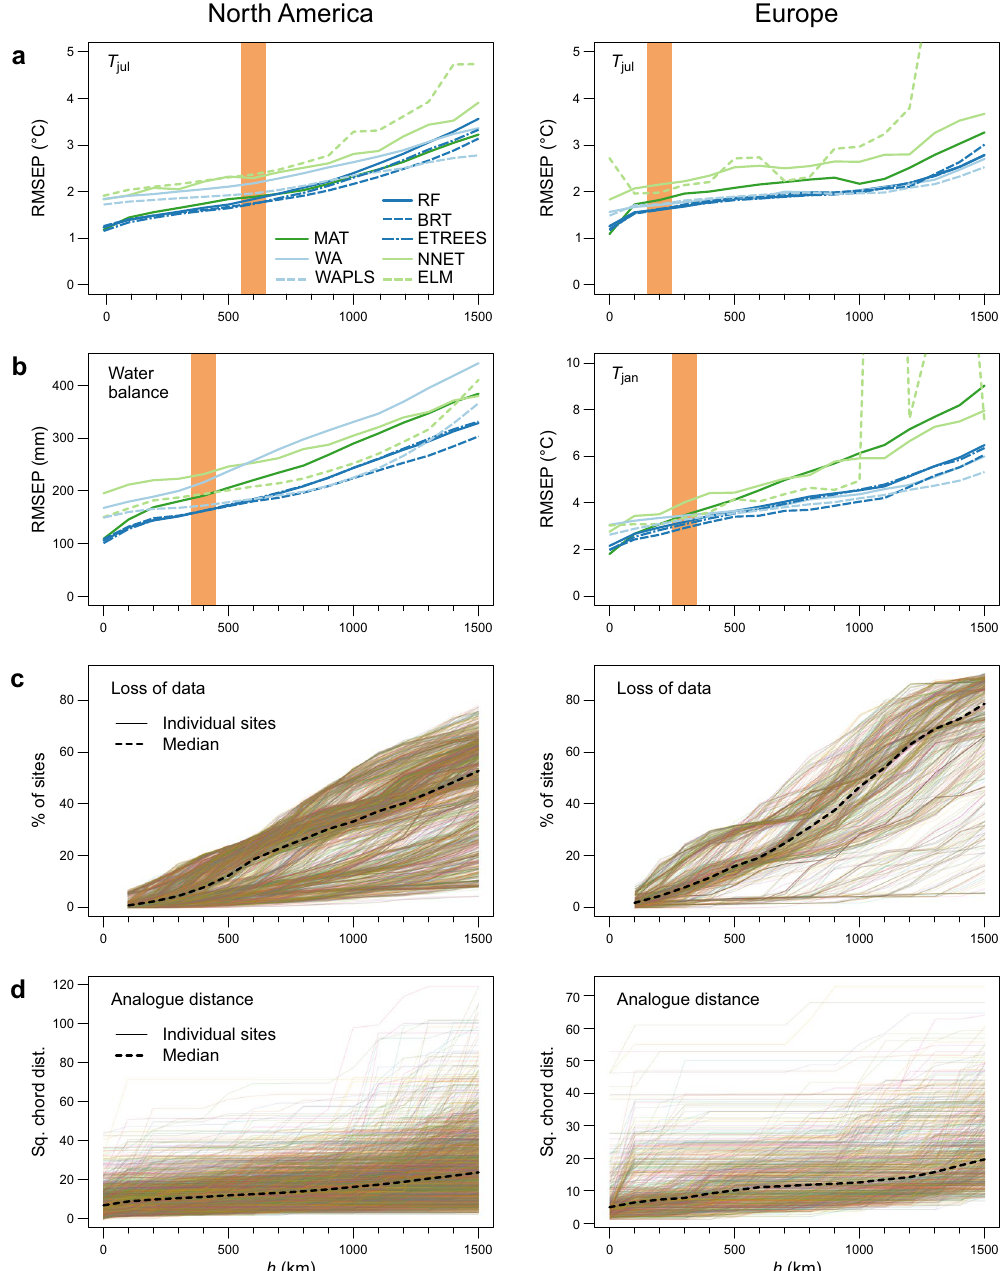
Figure 3. Cross-validation (CV) results. Results are shown with a series of h- block CV’s, with h increasing from 0 to 1500 km at 100 km increments (note: h = 0 is equivalent to leave-one-out CV). Orange bars indicate the best h , estimated based on the range of a variogram fitted to the residuals of a weighted averaging (WA) model. ( a ) Root-mean-square error of prediction (RMSEP) for the primary variable in North America and Europe (July mean temperature). ( b ) RMSEP for the secondary variable (water balance in North America, January mean temperature in Europe). ( c ) Loss of calibration data in CV models, shown for individual sites and as the median for all sites. ( d ) Compositional distance (squared chord distance) to best pollen analogue in CV models, shown for individual sites and as the median for all